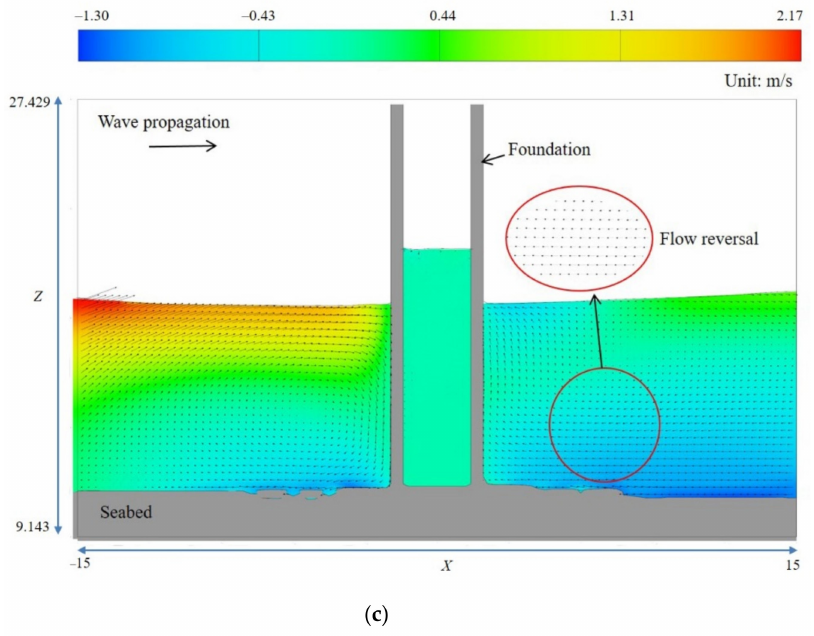
Figure 10. Velocity profile around USAF: ( a ) Flow runup and down stream at upstream anchor edges; ( b ) Horseshoe vortex at upstream anchor edges; ( c ) Flow reversal during wave through stage at lee side.